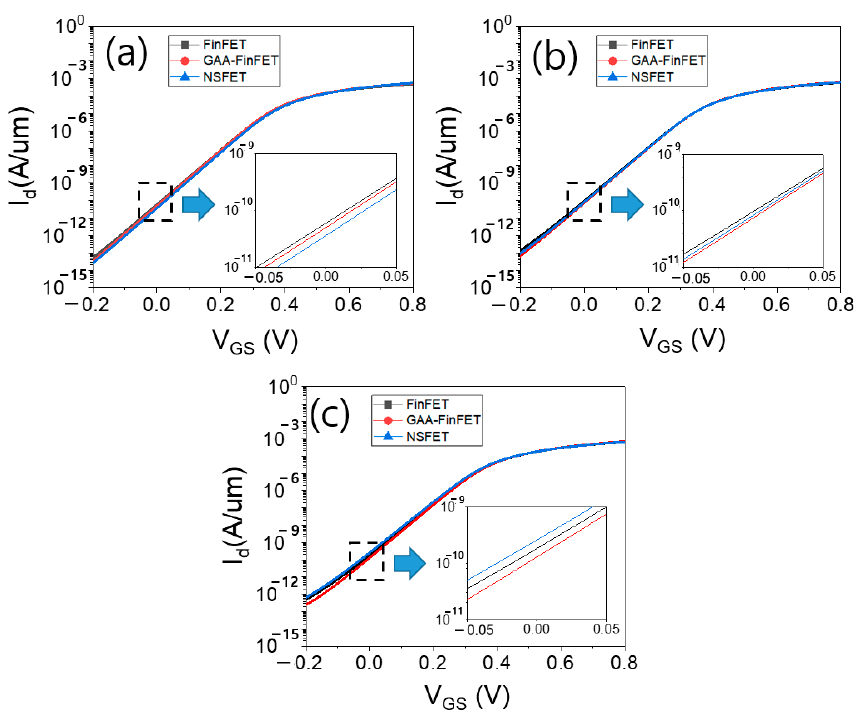
Figure 5. ( a ) SS sat , ( b ) DIBL, ( c ) R odlin4 , and ( d ) R odsat4 for three values of proximity (i.e., 8 nm, 5 nm, and 3 nm). Please note that the doping concentration in the sub-channel region is set to 1 × 10 18 cm − 3 .